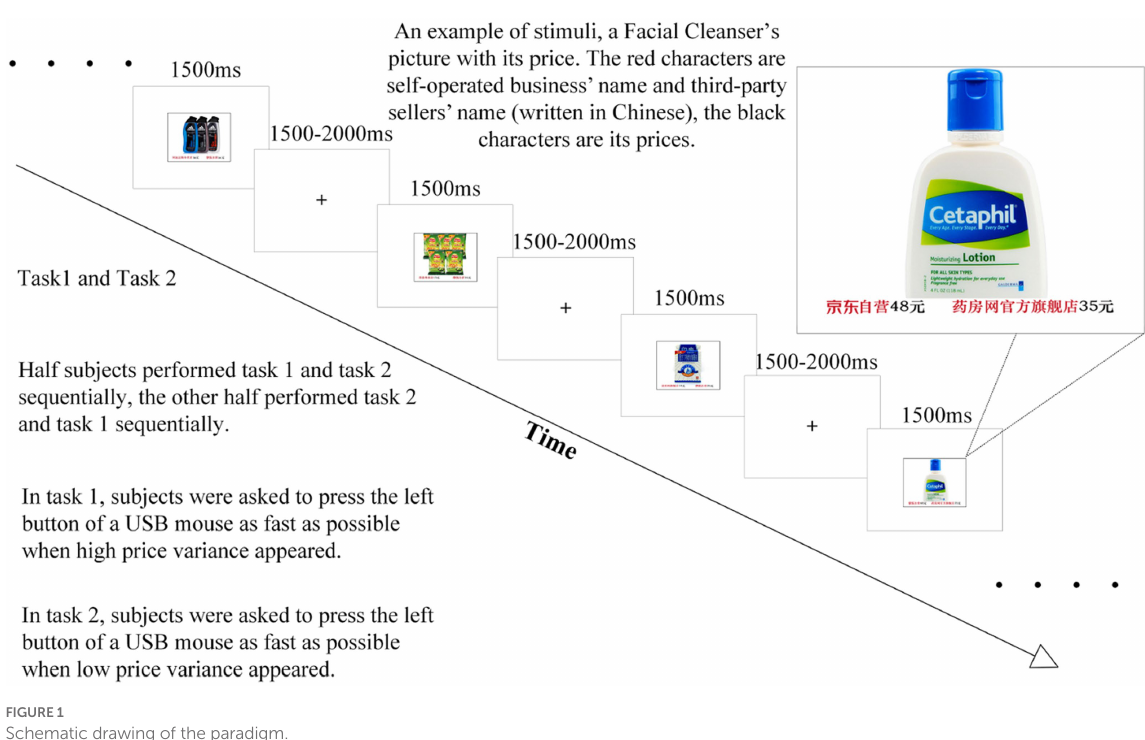
FIGURE 1 Schematic drawing of the